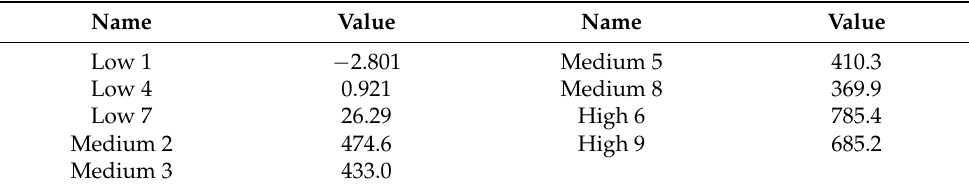
Table 3. Computed linguistic values of P based on the training data set.